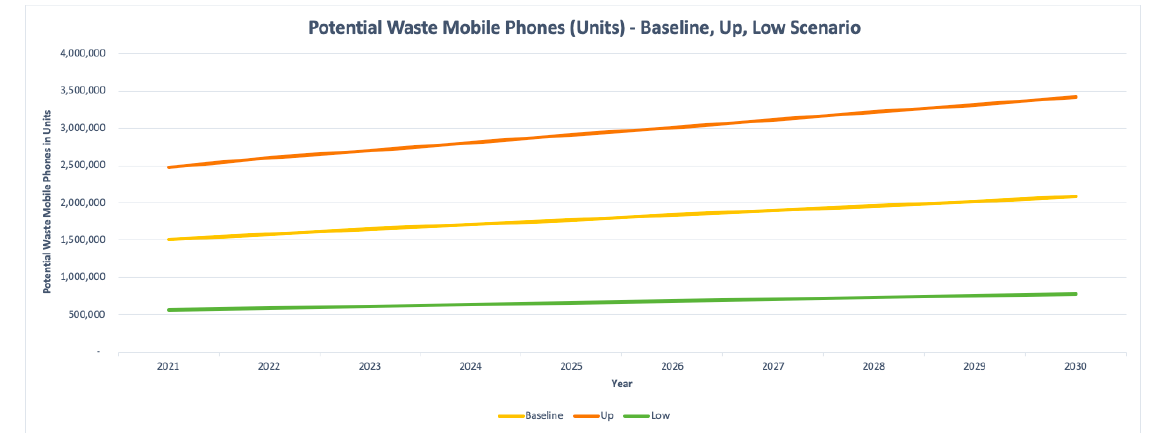
Figure 19. Obsolete/Discarded Mobile Phones Possible Pathways.